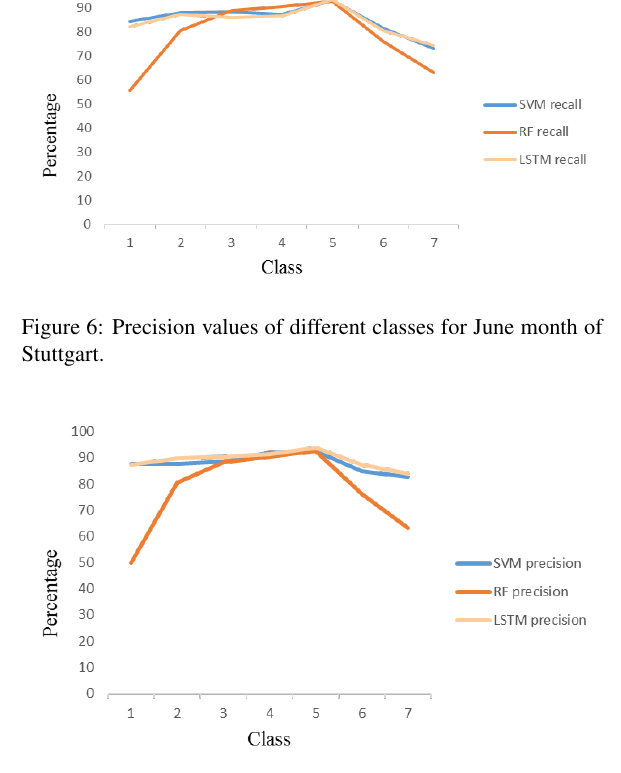
Figure 7: Recall values of different classes for June month of Stuttgart.